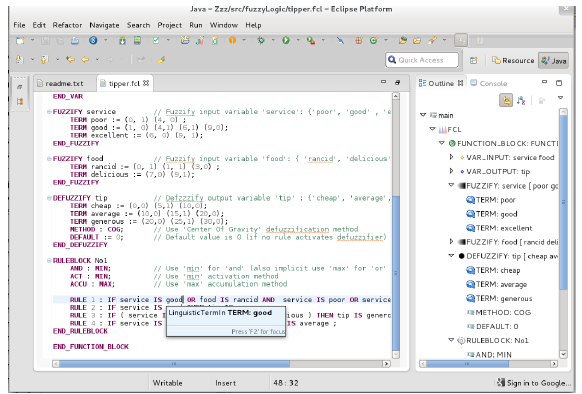
Fig. 6. FCL code edited in the Eclipse plugin.